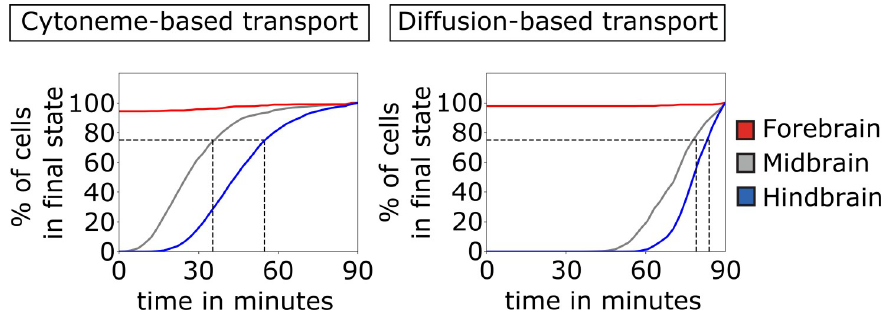
Fig 6. Quantification of pre-patterning. Comparison of the establishment of the three brain primordia based on cytoneme and diffusion-based transport. The percentage of cells that reach sufficient morphogen concentration to adopt their final cell fate (which is in this case determined by thresholding at t TRS = 90 min so that the tissue is split into thirds by cell numbers) is plotted over time. This is shown for forebrain (red solid line), midbrain (gray solid line), and hindbrain (blue solid line). The gray dashed lines mark the points in time where 75% of the midbrain and hindbrain cells adopted their final fate, respectively. After about 45 min, the majority of cells (75%) acquire their final fate if the ligand is transported on cytonemes. A diffusion-based distribution requires considerably longer time (about 80 min) to determine the cellular fate in the target tissue. The values are averaged over 100 simulations.